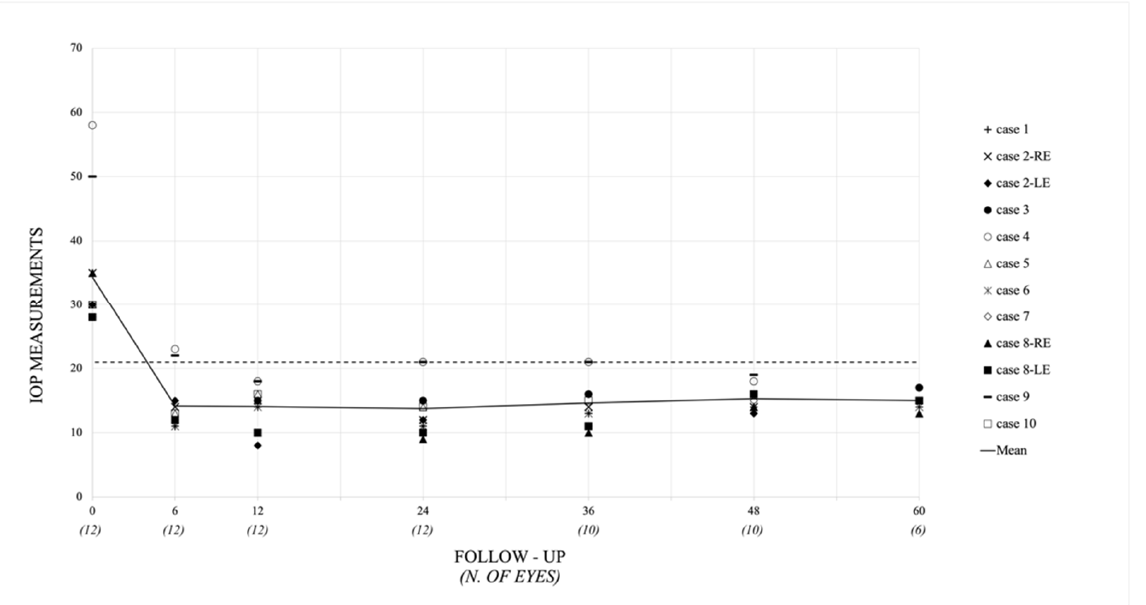
Figure 3. Scatterplot of preoperative and postoperative intraocular pressure (IOP) (mmHg) ( Y axis) and follow-up (months) ( X axis). The value of IOP for each patient is represented at different postoperative time intervals. The dashed line indicates the 21 mmHg IOP value. The solid line indicates the mean IOP value. For children who underwent surgery in both eyes, IOP values are represented independently (RE, right eye; LE, left eye). N = number.